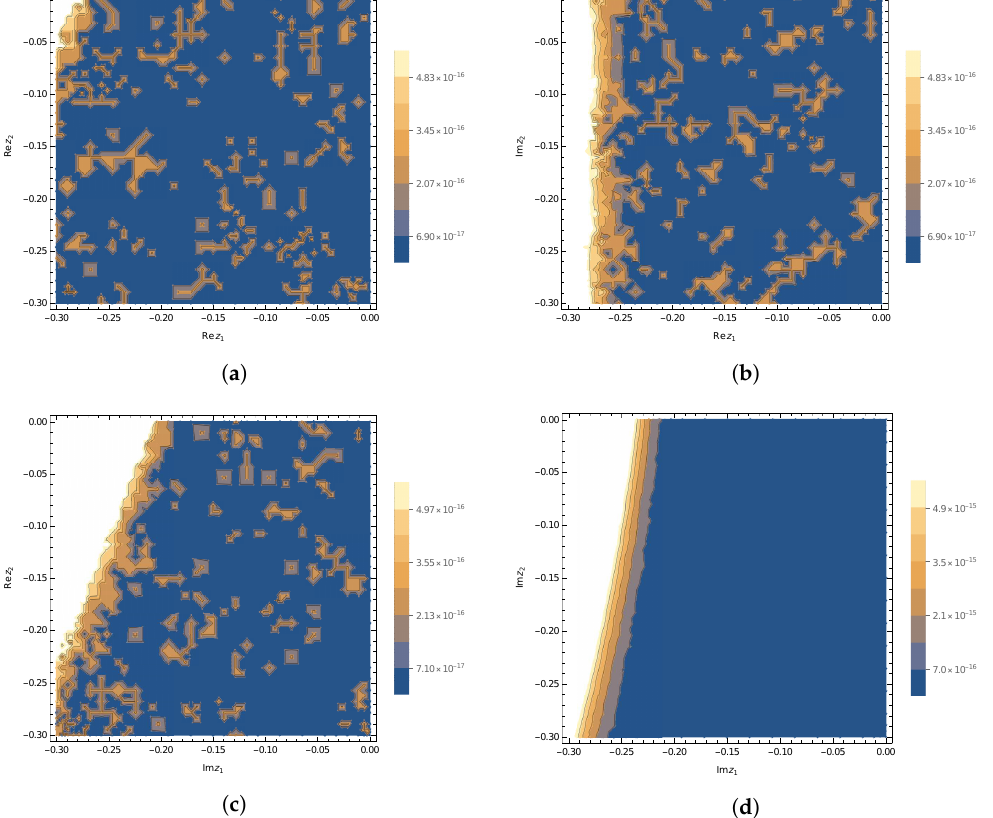
Figure 4. The plots where the approximant f 20 ( z ) of BCF (36) guarantees certain truncation error (cid:112) ( bounds for function ( 1 − z 2 + 1 − z 2 ) 2 − 4 z 1 )